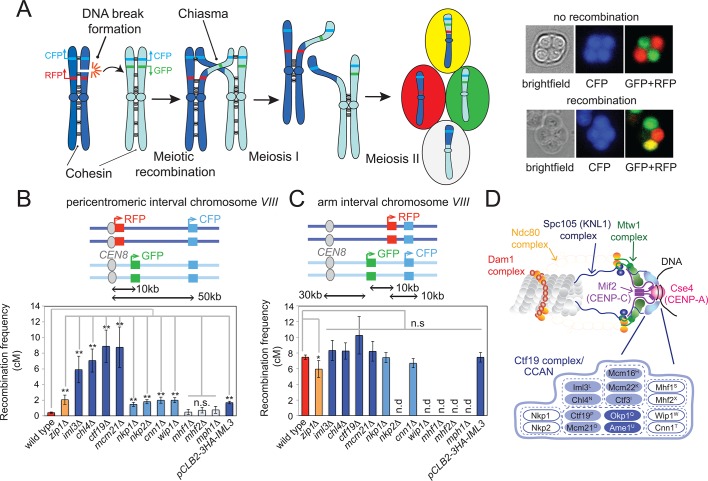
The Ctf19 kinetochore sub-complex represses pericentromeric meiotic recombination.(A) Scheme of meiosis and the live cell reporter assay to measure CO recombination. Homologous chromosomes are shown in light and dark blue with Green fluorescent protein (GFP), tdTomato (RFP) and m-Cerulean (CFP) reporters represented in green, red and cyan, respectively. Expression of reporters in spores leads to segregation of coloured markers as indicated in the images of live tetrads. (B, C) Map distances (centiMorgans (cM)) and standard error (bars) were determined for a ~10 kb pericentromeric (B) or chromosomal arm (C) interval as described in Materials and methods. p-values were obtained using Fisher’s exact test (* p<0.05; ** p<0.0001). (D) Schematic representation of the kinetochore showing yeast Ctf19 sub-complex components with superscripts indicating the centomere protein (CENP) equivalent in humans. Proteins essential for vegetative growth or proper spore viability after meiosis are shown in dark and light blue, respectively. CO, crossover; n.d., not determined.